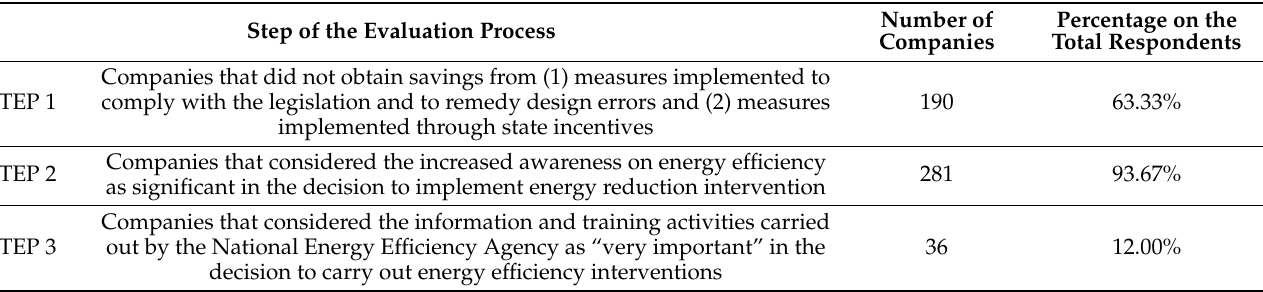
Table 2. Number of companies and associated percentage on the total of respondents identified in the first three steps (STEP 1–STEP 2–STEP 3) of the evaluation